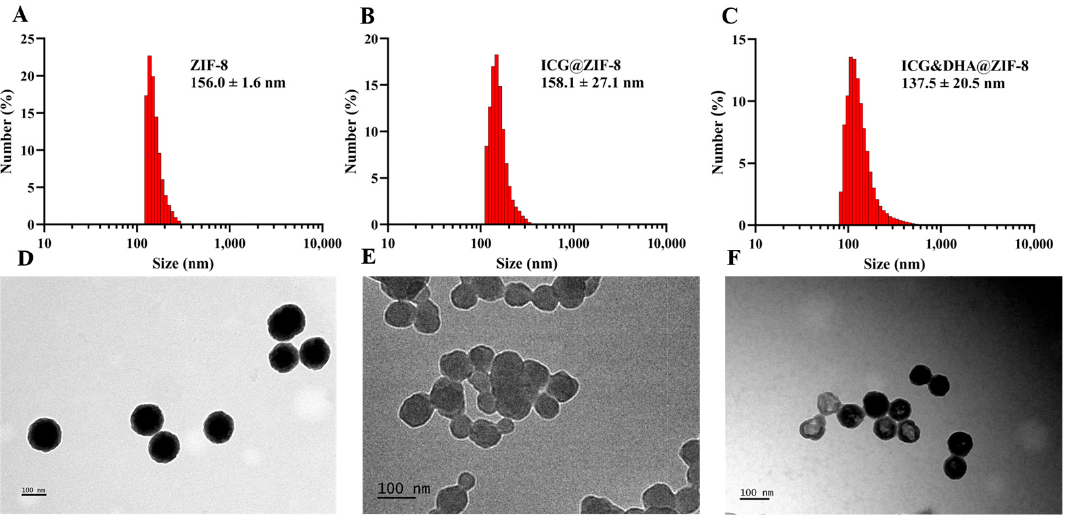
Figure 1. ( A – C ) Dynamic light-scattering results of ZIF-8, ICG@ZIF-8 and ICG&DHA@ZIF-8. ( D – F ) Representative transmission electron microscopy images of ZIF-8 ( D ), ICG@ZIF-8 ( E ), and ICG&DHA@ZIF-8 ( F ). Scale bars, 100 nm.